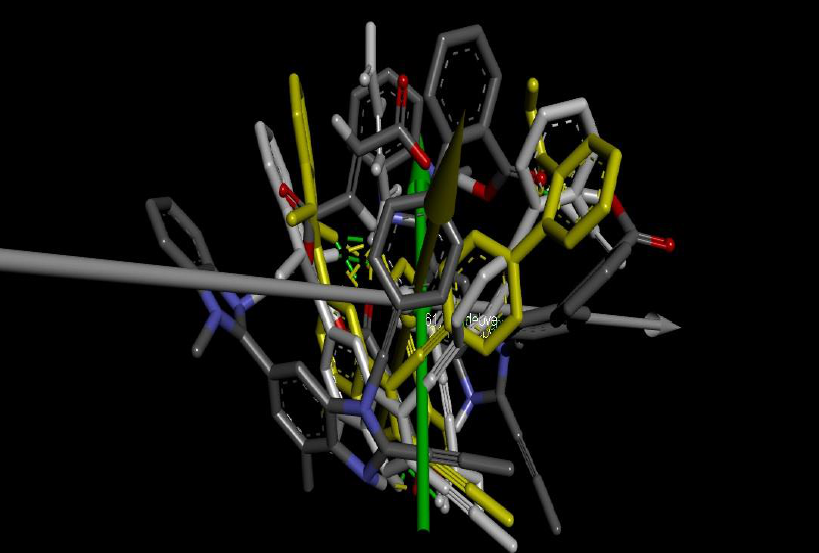
Figure 4. Superimposition of various cocrystallizing systems with increasing molar ratio.